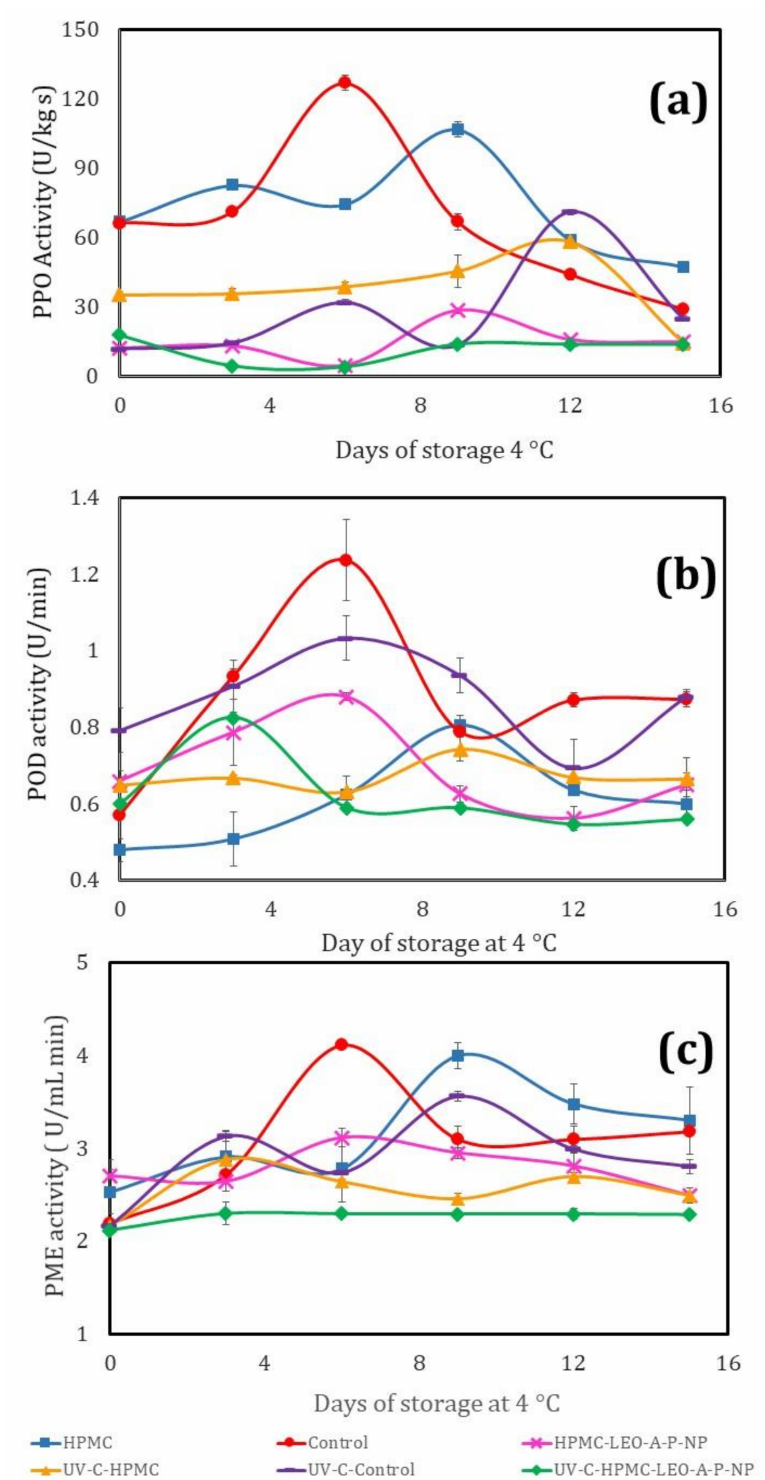
Figure 4. ( a ) PPO activity during storage on fresh-cut cucumber; ( b ) POD activity on fresh-cut cucumber; ( c ) PME activity changes during storage at 4 ◦